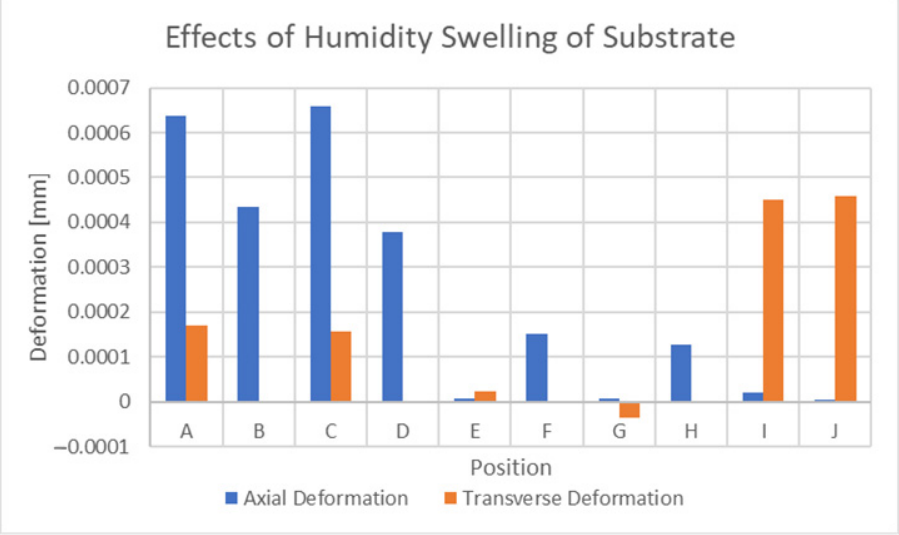
Figure 19. Effects of humidity-based swelling at 100% RH.